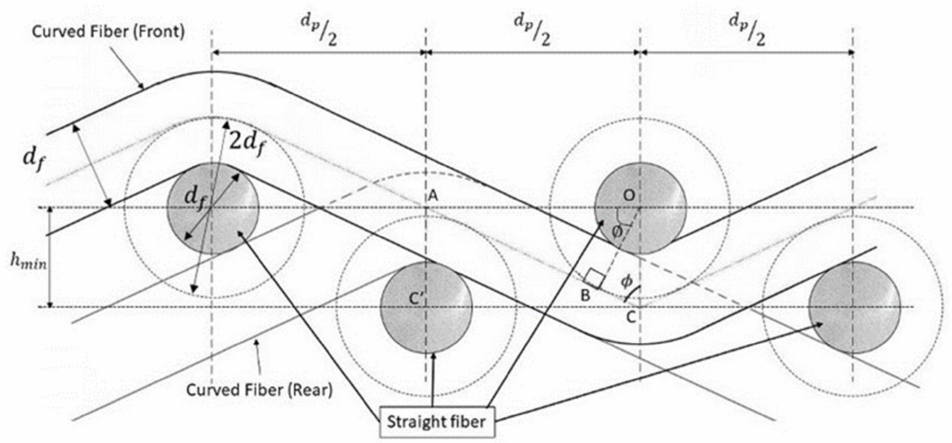
Figure 7. Description of parameters for closely packed wire-mesh layers in staggered type of